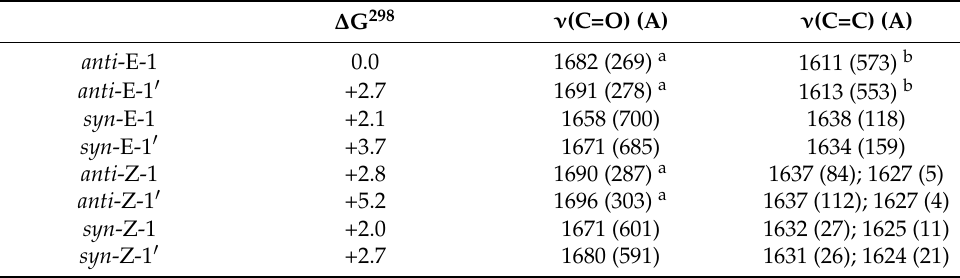
Table 1. Calculated CO and CC frequencies (in cm − 1 , scaled by 0.95 [51], intensities (in km/mol), and relative energies of isomers (in kcal/mol).